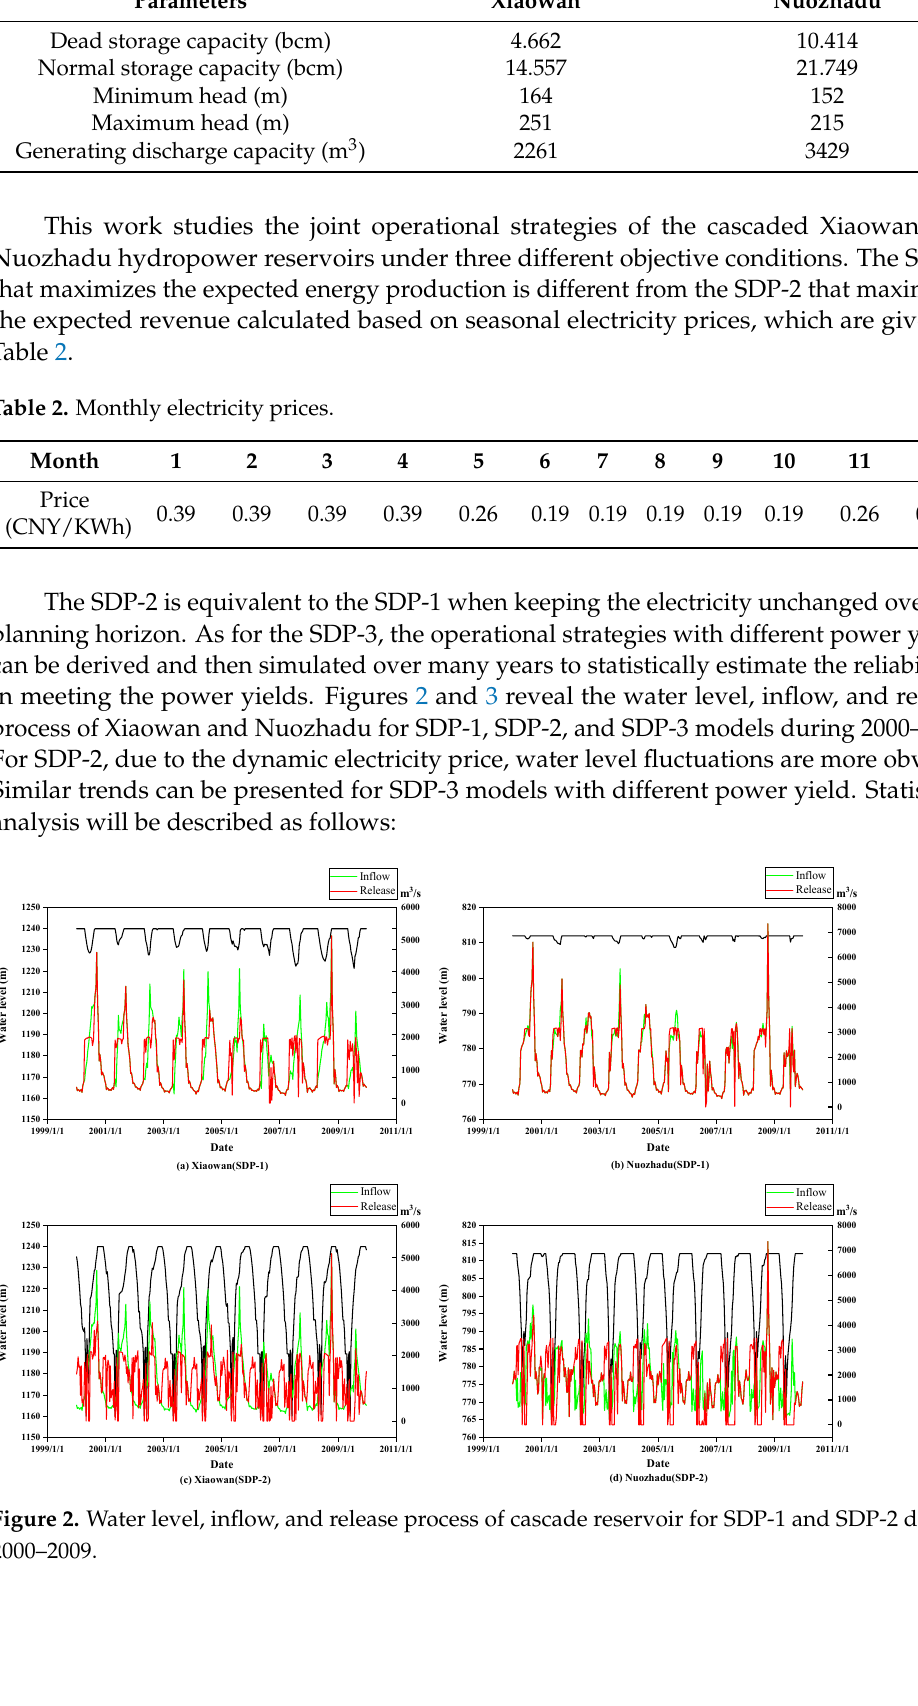
m 3 /s Figure 3. Water level, inflow, and release process of cascade reservoir for SDP-3 with power yield = 500 MW and 5000 MW during 2000–2009.